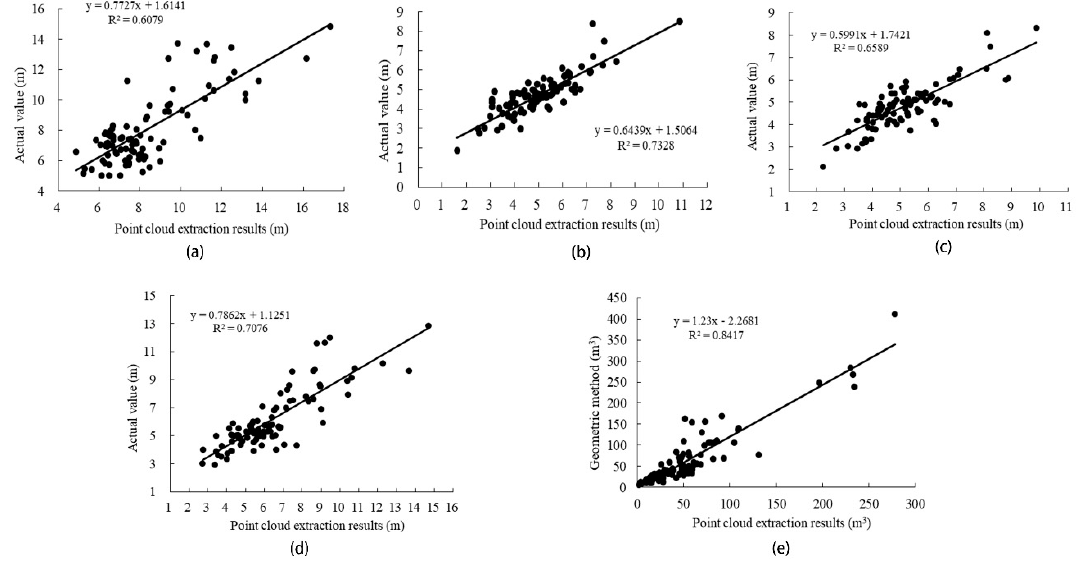
Figure 6. Scatter plots of the relationship between extracted tree attributes and the true values. ( a ) Tree height vs. the true value; ( b ) X crown width vs. the true value; ( c ) Y crown width vs. the true value; ( d ) crown height vs. the true value; and ( e ) crown volume calculated using the voxel method vs. the optimal value.